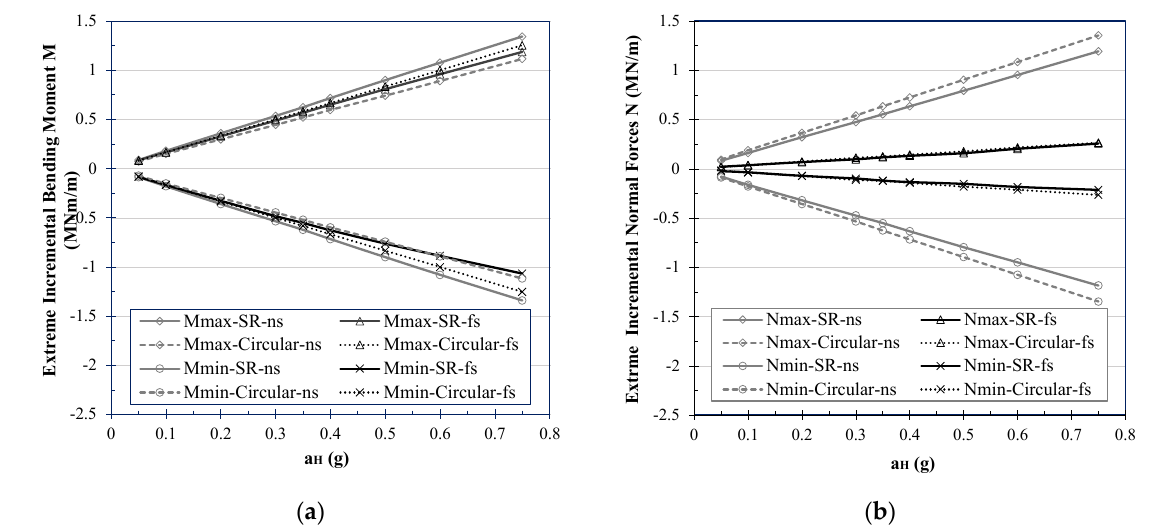
Figure 10. Effect of the a H value on the internal forces of circular and sub-rectangular tunnel linings. ( a ) Incremental bending moments; ( b ) incremental normal forces.